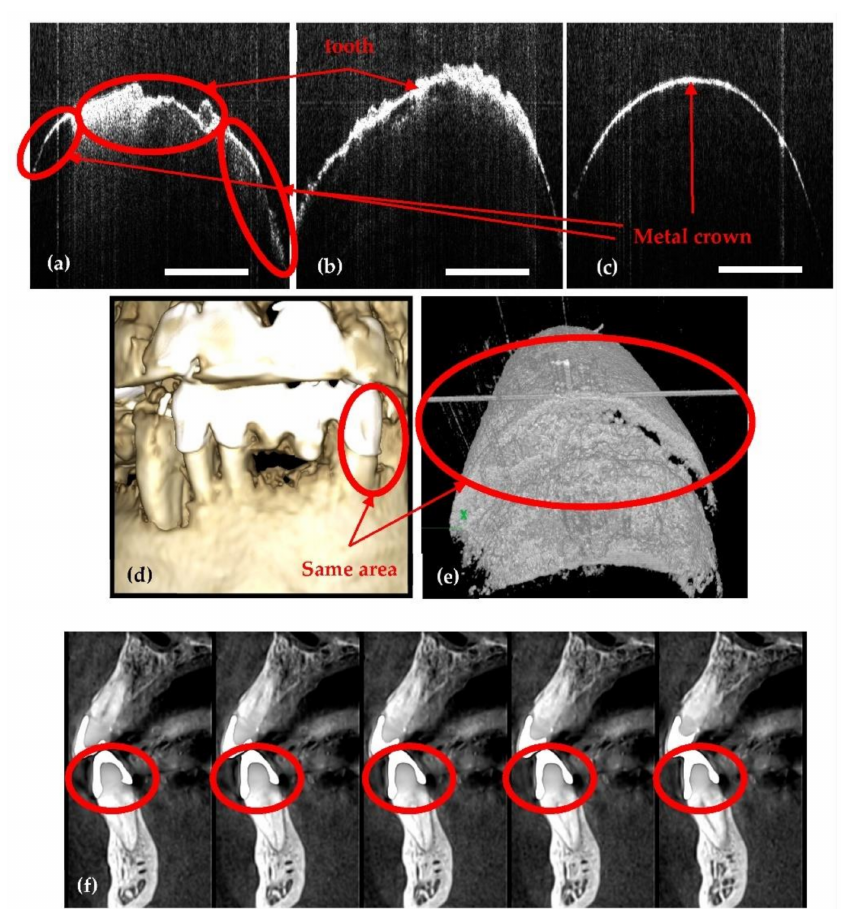
Figure 4. An example where OCT spots dental details near metal crowns. ( a – c ) OCT B-scans; ( d ) 3D rendering of CBCT; ( e ) OCT 3D reconstruction; ( f ) 3D CBCT sagittal view of the tooth. Scale: 1 mm. In the case presented in Figure 5, the tooth marked with red must be extracted because an orthodontic treatment is mandatory, i.e., the extracted tooth has been blocking the tooth marked with blue in Figure 5d. On the radiographs it can be observed that the extracted tooth looks healthy, as no cavities are visible. After the extraction, the tooth is investigated with OCT, and a small cavity is observed on the enamel level. OCT resolution made possible even the assessment (i.e., exact measurement) of the cavity. Although this example refers to an extracted tooth, the capability of OCT to correctly assess and diagnose small cavities for in vivo investigations has been approached, as well